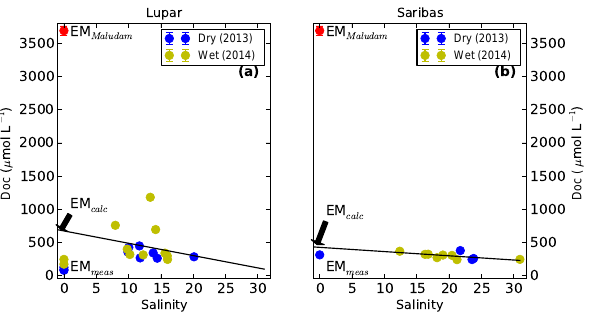
Figure 4. Carbon-to-nitrogen (C / N) ratios in dissolved organic matter (a) and in particulate organic matter (b) . Blue markers re- fer to samples from 2013; yellow markers refer to samples from 2014. The individual rivers are denoted by different symbols. Lines refer to the C / N ratios that would be expected for tropical peat and leaves (Baum, 2008) and for phytoplankton. Note that DON data shown in panel (a) were only available in